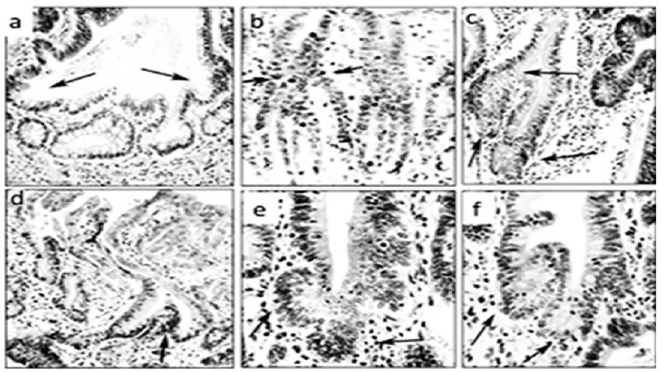
Fig 5. Corrupted colonic crypts showing top-down replacementby dysplastic epithelium from a conventional adenoma on top. a : Note non-dysplastic corrupted crypts underneatharrows, b : Two corrupted crypts with high grade dysplasia,the one on the left with additionalasymmetric lateral fission (at arrows), c-f : Corruptedcoloniccrypts lined with dysplastic epithelium, d : Three-armcrypt, at arrow. (DMH- treated rats, hematoxylin-eosin, a, b : x10, c, d x10, e, f :